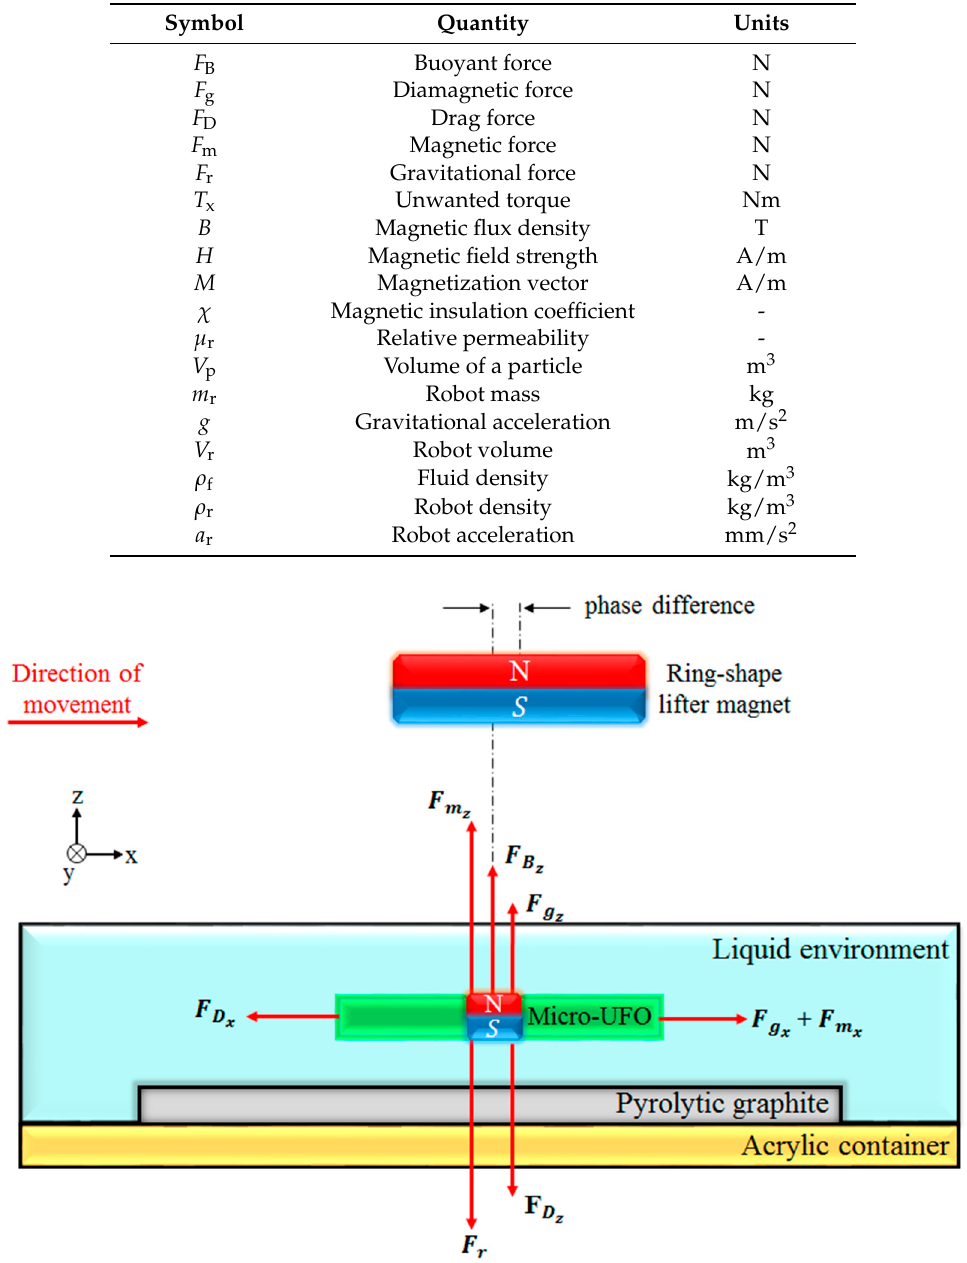
Table 1. System Model Parameters.